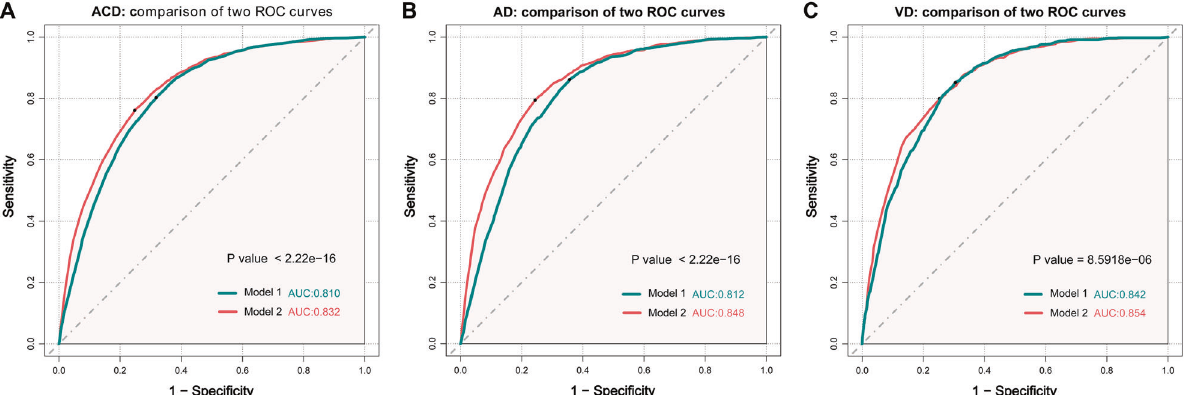
Fig. 2 ROC curves show the performance of the dementia risk scores in predicting the risk of dementia. The AUC for model 1 was 0.810 (95% CI 0.804 – 0.816) for ACD ( A ). The AUC for model 1 was 0.812 (95% CI 0.804 – 0.820) for AD ( B ). The AUC for model 1 was 0.842 (95% CI 0.832 – 0.853) for VD ( C ). The AUC for model 2 was 0.832 (95% CI 0.826 – 0.838) for ACD. The AUC for model 2 was 0.848 (95% CI 0.840 – 0.856) for AD. The AUC for model 2 was 0.854 (95% CI 0.843 – 0.865) for VD. ACD all-caused dementia, AD alzheimer ’ s disease, VD vascular dementia, ROC receiver operating model 2 (Figs. 3 and 4). Cox regression analyses suggested that Speci fi city = 0.643), and the best cut-off was identi fi ed to be the the dementia risk scores were strong prognostic indicators for score value of 83 points or more for VD (AUC = 0.842, p < 8.59E-6, ACD, AD and VD in these two models. In the model 1, the hazard Sensitivity = 0.852, Speci fi city = 0.696). In the model 2, the best ratios for ACD were 1.039 (continuous) and 7.541 (HR vs. LR), the cut-off was identi fi ed to be the score value of 98 points or more hazard ratios for AD were 1.039 (continuous) and 8.595 (HR vs. for ACD (AUC = 0.832, Sensitivity = 0.760, Speci fi city = 0.753), the LR), and the hazard ratios for VD were 1.049 (continuous) and best cut-off was identi fi ed to be the score value of 100 points or 11.810 (HR vs. LR) (Table 3). In the model 2, the hazard ratios for more for AD (AUC = 0.848, Sensitivity = 0.794, Speci fi city = 0.757), ACD were 1.040 (continuous) and 8.348 (HR vs. LR), the hazard and the best cut-off was identi fi ed to be the score value of 98 ratios for AD were 1.044 (continuous) and 10.550 (HR vs. LR), and points or more for VD (AUC = 0.854, Sensitivity = 0.799, Speci fi - the hazard ratios for VD were 1.045 (continuous) and 10.400 (HR city = 0.747) (Fig. 2). We selected the cut-off value for HR as 81 or vs. LR) (Table 3). In the competing risk analyses, patients in HR more in model 1 and 98 or more in model 2. groups had higher dementia risk compared to the LR groups Kaplan-Meier survival analyses suggested that patients in the when considering death as competing risk ( p < 0.0001) (Addi- HR group had faster clinical progression (plogrank < 0.0001) tional Fig. 1 and Additional Fig. 2). compared with those in the LR group, either in model 1 or in